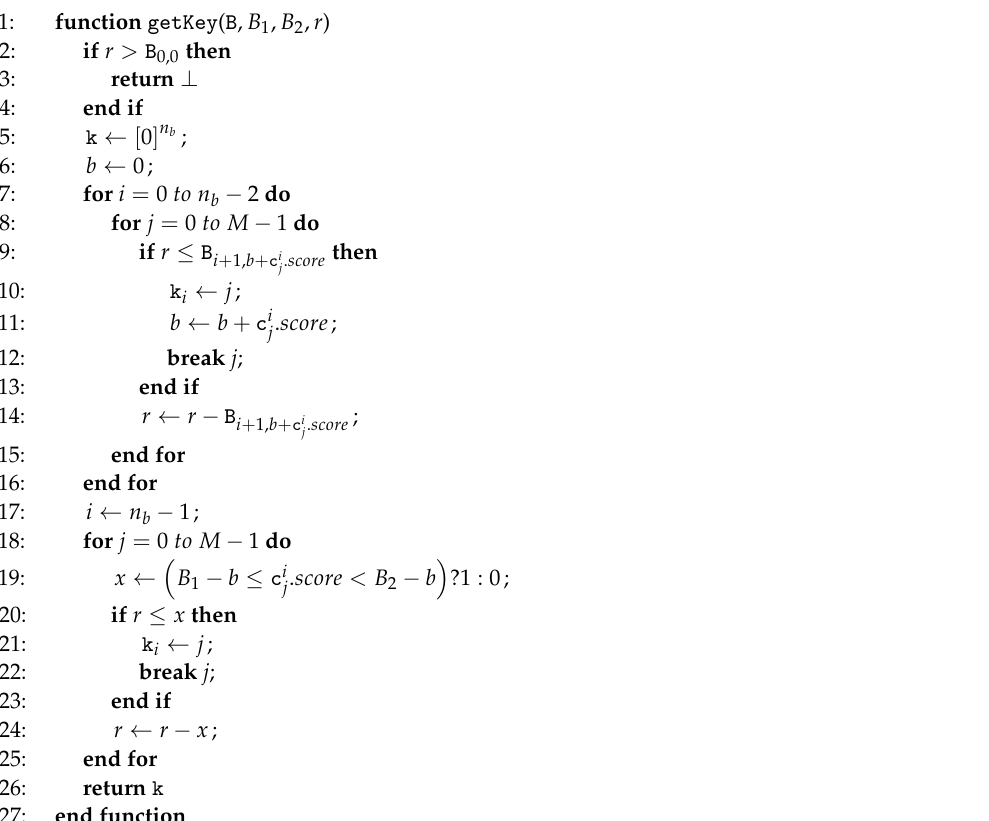
Algorithm 8 returns the r th full key candidate with weight in the interval [ B 1 , B 2 )